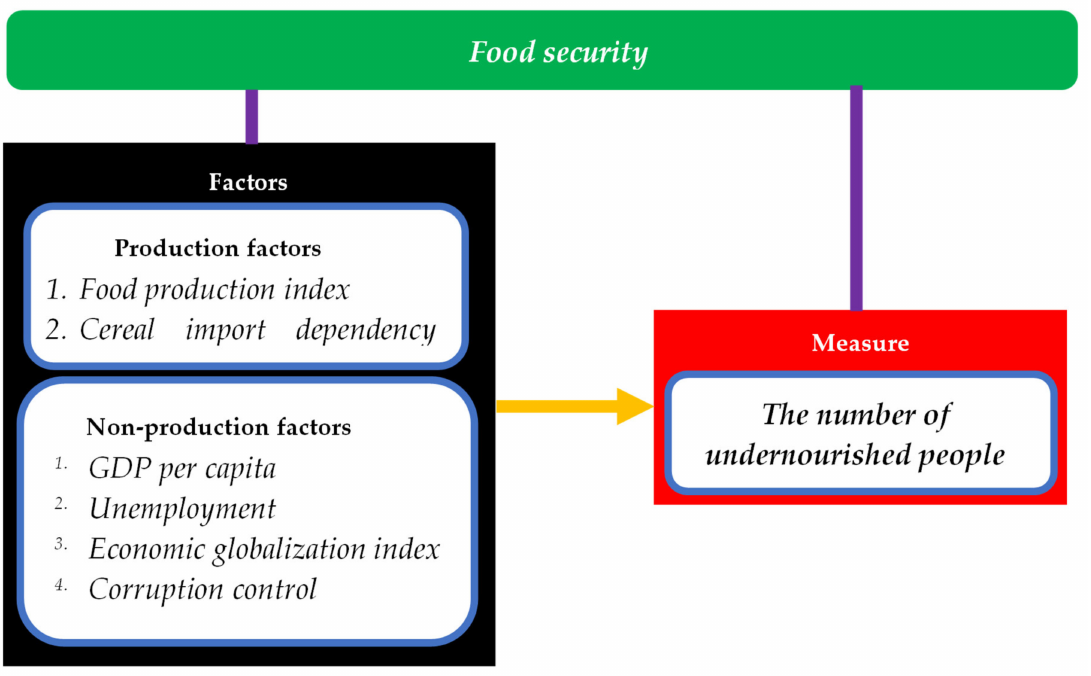
Figure 1. The theoretical framework for this